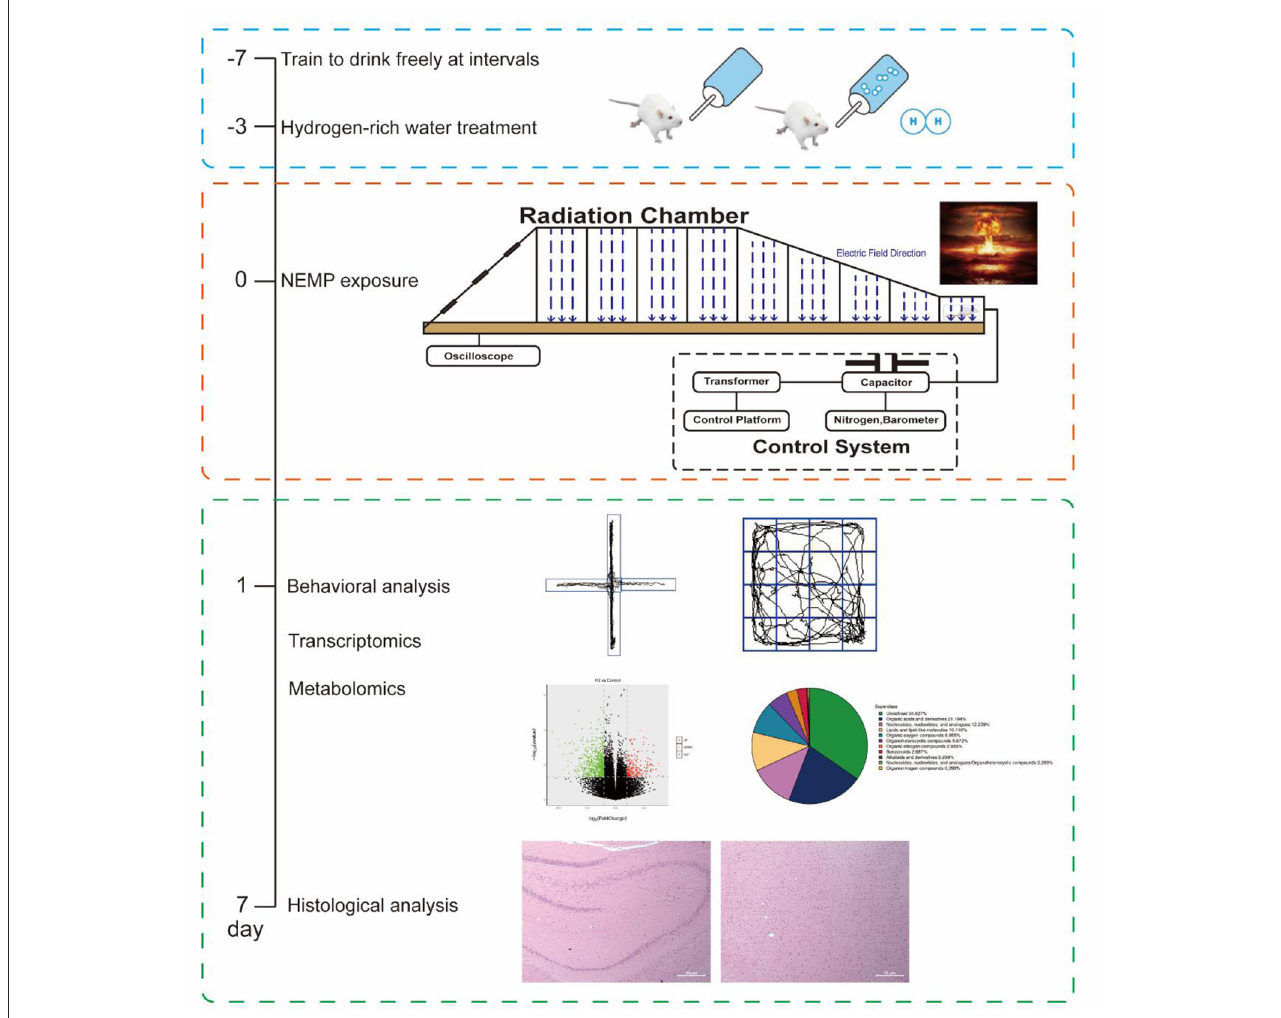
FIGURE1 Schematic workflow of the research process and some of the representative images from the